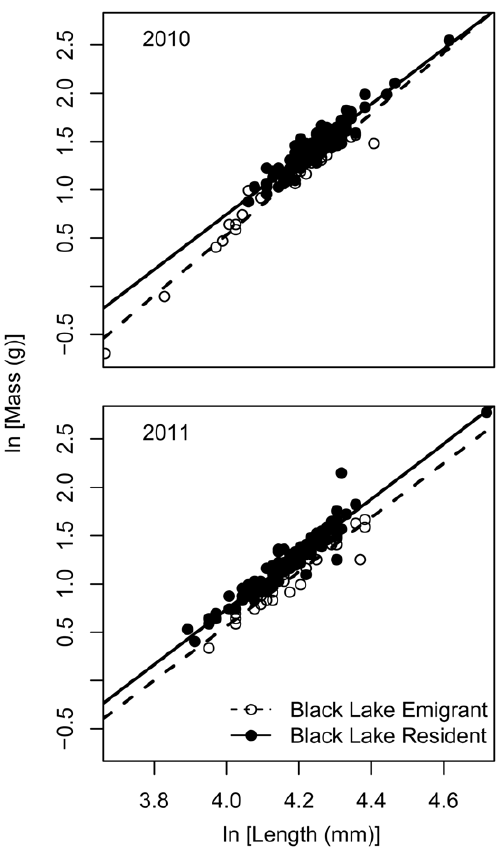
Figure 4. Length-mass relationship for sockeye salmon of Black Lake origin by lake of capture. These population sub-groupings are referred to in the text as Black Lake emigrants and Black Lake residents. Circles are individual fish and the lines represent the AICc selected model. For 2010, the best fit model contained different intercepts and slopes by lake of capture. For 2011, the model shown has the same intercept but different slopes by lake of capture. This model had only slightly greater support than two other models (see Table 2).